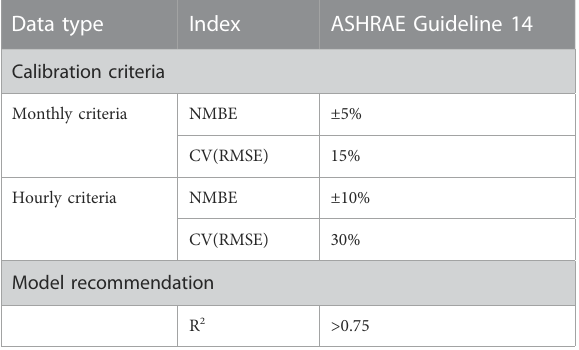
TABLE 4 Validation criteria provided by the ASHRAE Guideline 14.